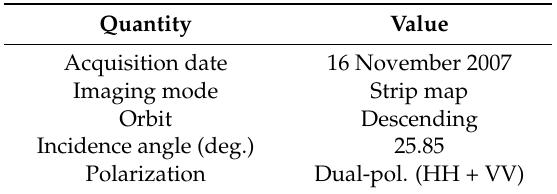
Figure 1. ( a ) Kerch Strait study area shown in the TerraSAR-X image acquired on 16 November 2007. The star denotes the location of the Volganeft-139 accident. ( b ) Magnified image of the oil spill area. ( c ) Magnified image of a biogenic film region. Table 1. Characteristics of TerraSAR-X Used in this